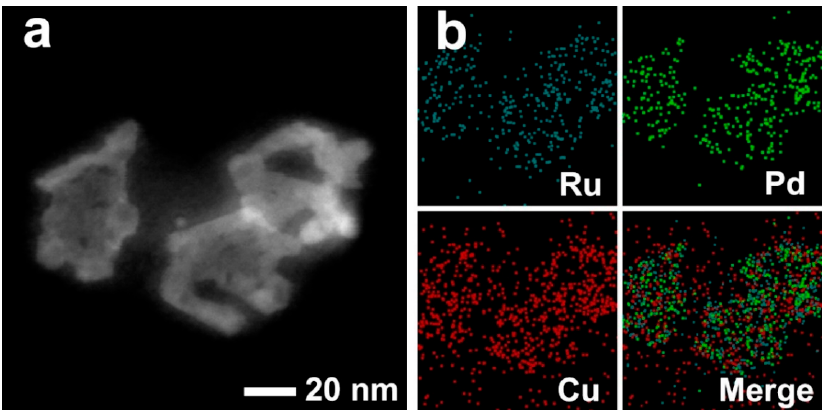
Figure 3. ( a ) HAADF-STEM and ( b ) EDX mapping images of the Pd 32 Cu 33 Ru 35 nanoplates.